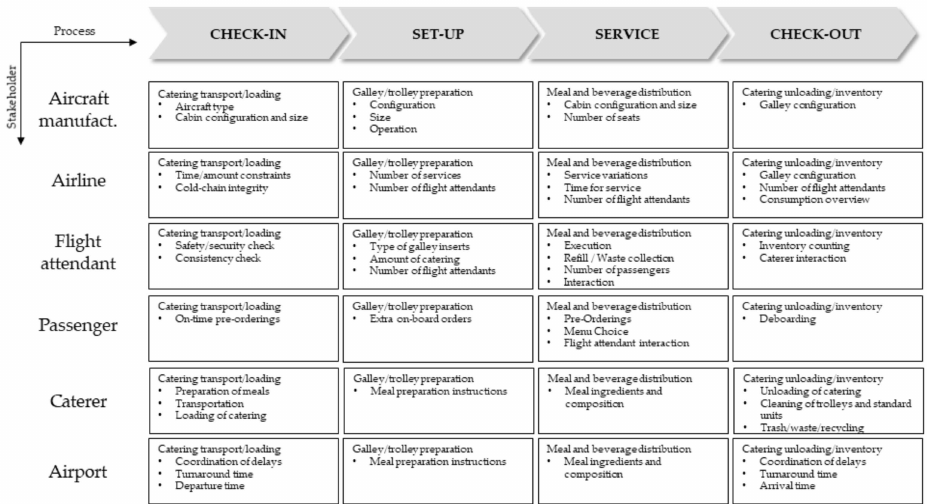
Figure 13. Four main steps of inflight catering services with